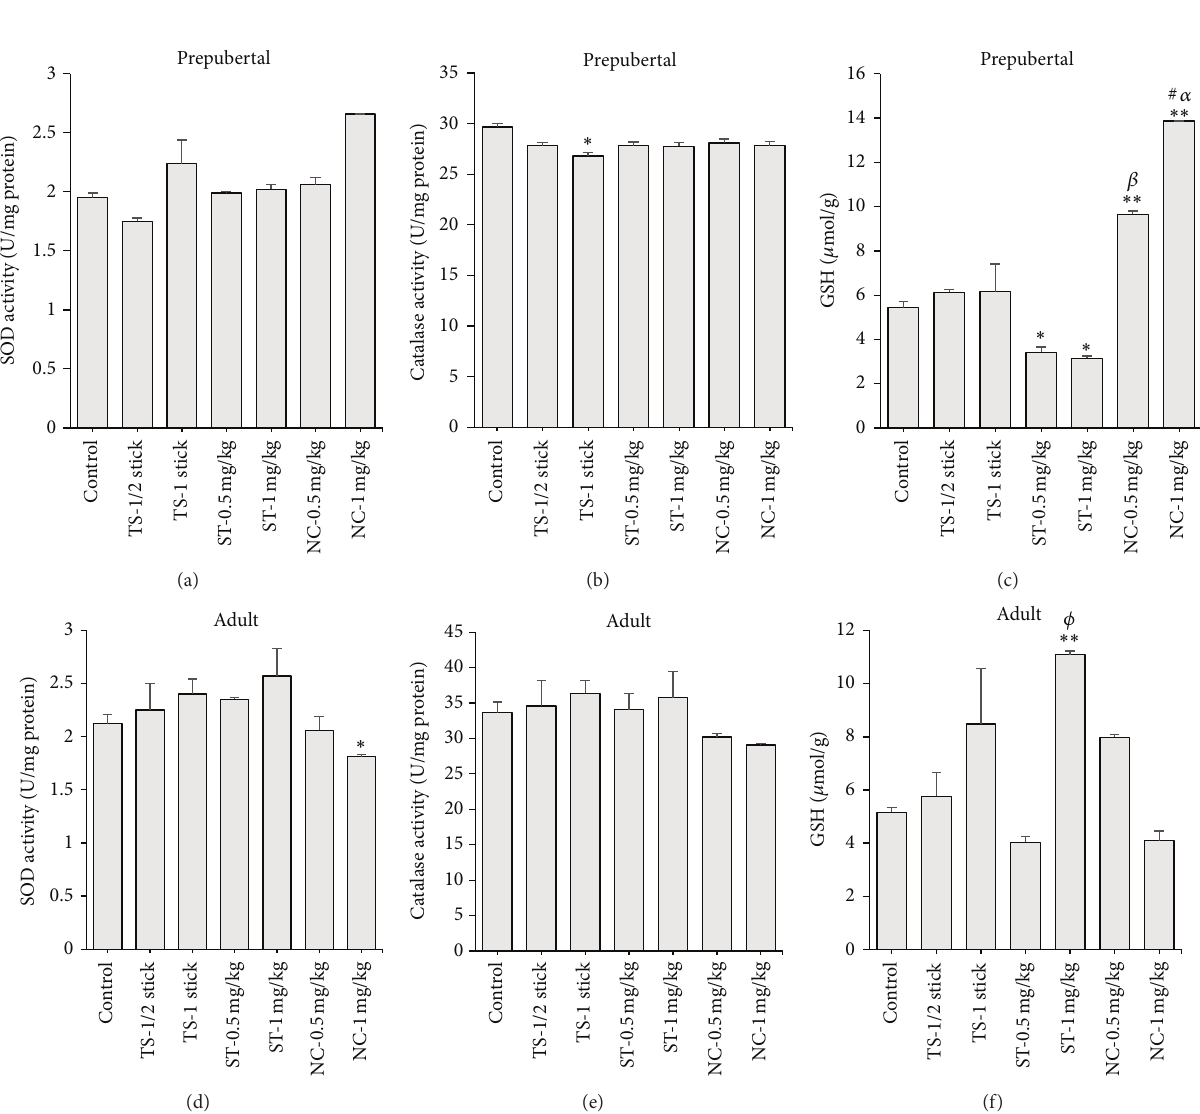
Figure 4: Activities of superoxide dismutase (SOD), catalase, and levels of reduced glutathione (GSH) in testis of prepubertal ((a), (b), and (c)) and adult rats ((c), (d), and (e)) following daily exposure to cigarette smoke (tobacco smoke, TS), smokeless tobacco (ST), and nicotine for 30 days. Data are expressed as mean ± SEM ( 𝑛 = 6 ). ∗ 𝑝 < 0.05 compared to control; ∗∗ 𝑝 < 0.01 compared to control; 𝛽 𝑝 < 0.05 compared to ST-0.5mg/kg.; # 𝑝 < 0.05 compared to TS-1 stick; 𝛼 𝑝 < 0.01 compared to ST-0.5 mg/kg; 𝛿 𝑝 < 0.05 compared to ST-0.5 mg/kg and NC-0.5mg/kg; 𝜙 𝑝 < 0.05 compared to